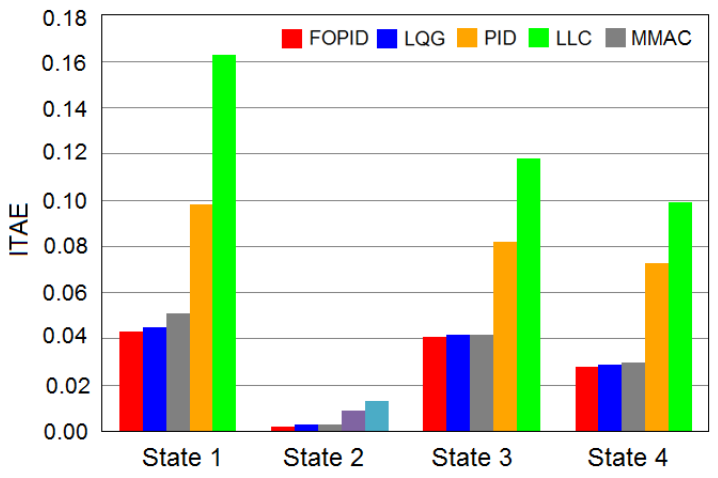
Figure 18. Power system frequency at bus 6 for scenario 3: ( A ) state 1, ( B ) state 2, ( C ) state 3, and ( D ) state 4.